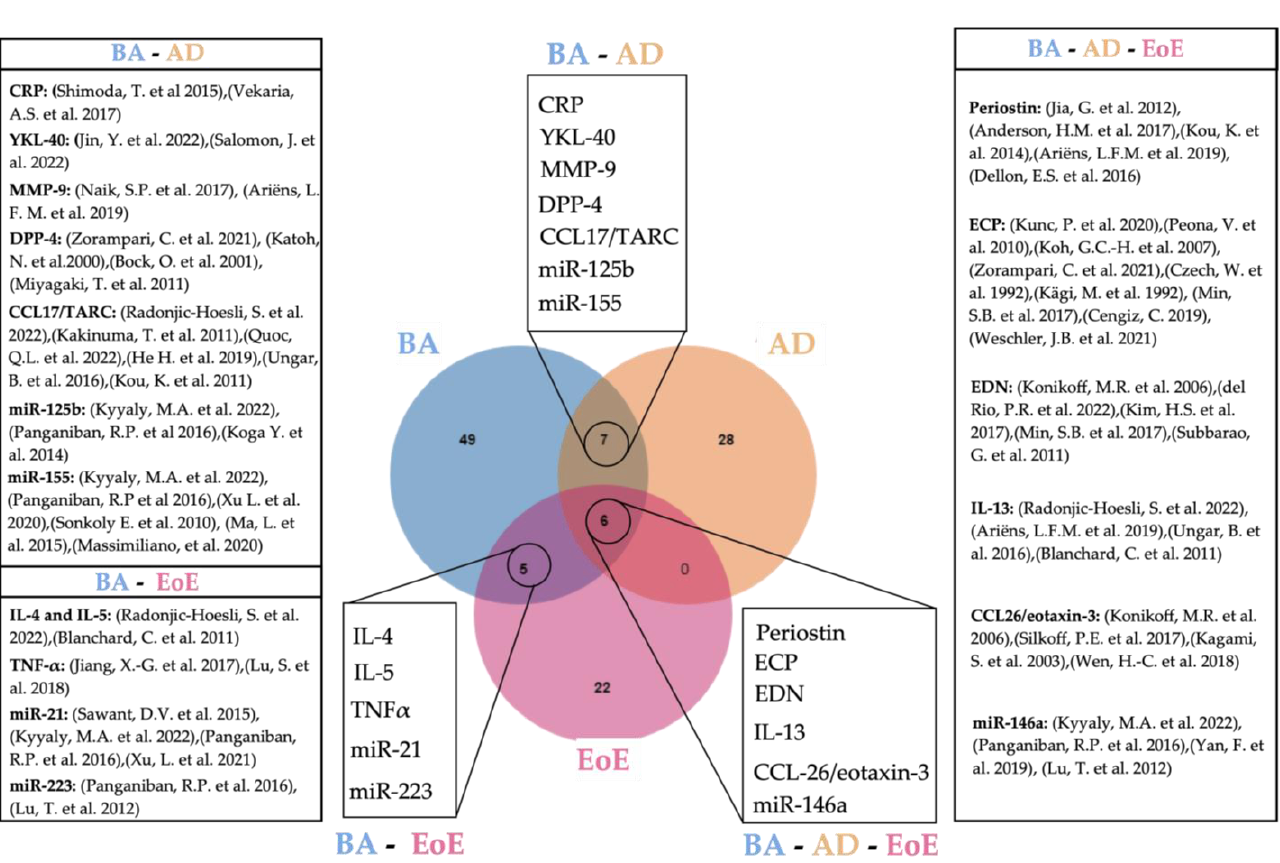
Figure 1. Venn diagram showing overlapping circulating biomarkers for BA, AD, and EoE [16,19,47–49,54–62,65–68,83–85,92–94,99–103,107,108,114,118,122,123,136–139,144,148,150–154,157,160,165]. Created with Jvenn diagram viewer [173]. BA: bronchial asthma, AD: atopic dermatitis, EoE: eosinophilic esophagitis.